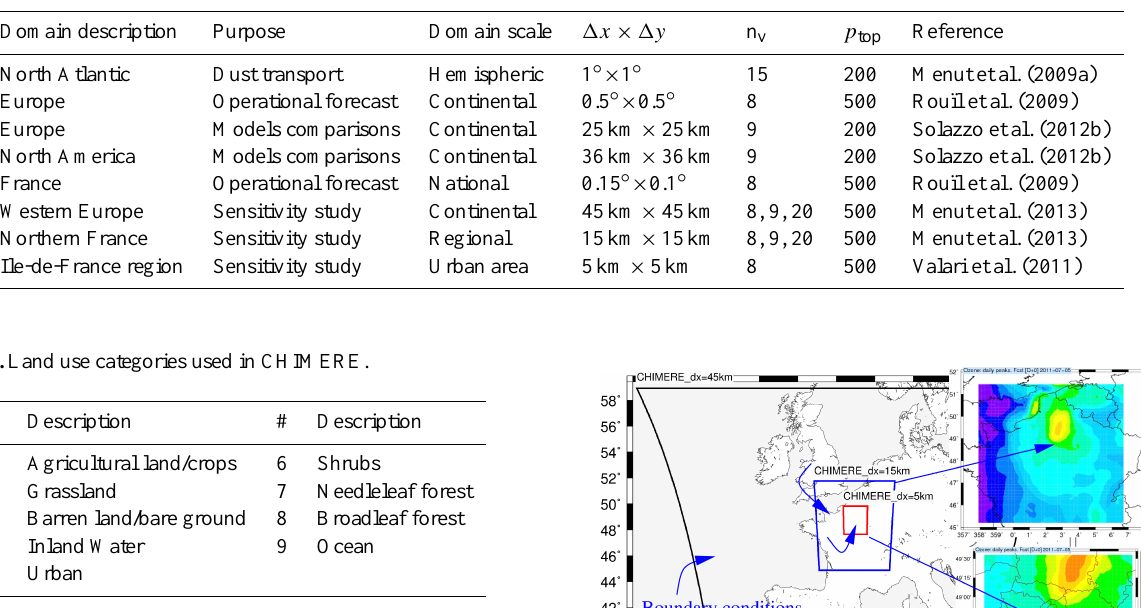
Table 1. Examples of some domains for which CHIMERE simulations have been performed, with their horizontal resolution, ∆ x and ∆ y , their number of vertical levels, n v and the domain top, p top , in hPa.